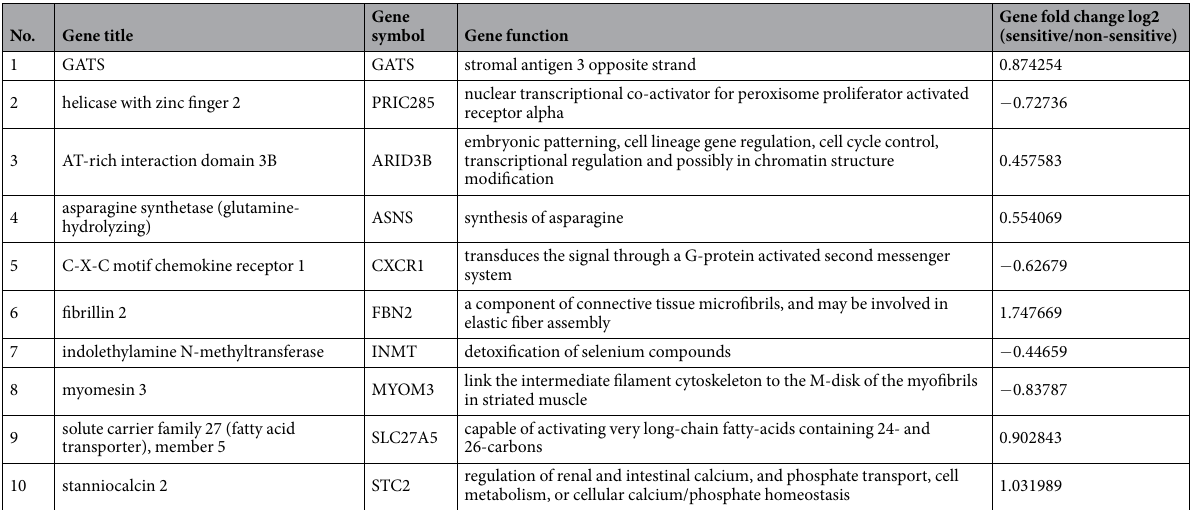
Table 3. A list of genes that could predict the response in our SVM